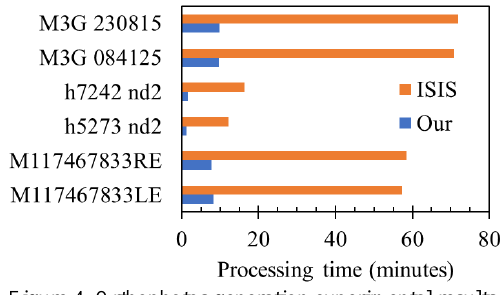
Figure 4. Orthophotos generation experimental